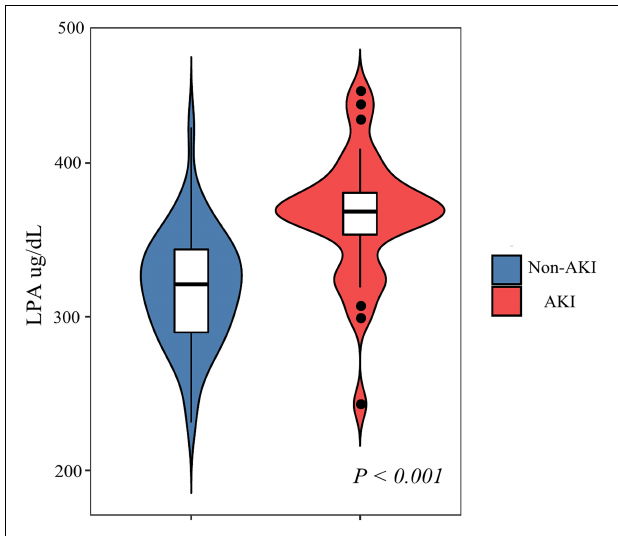
FIGURE 1 | Comparison of admission LPA stratified by AKI.